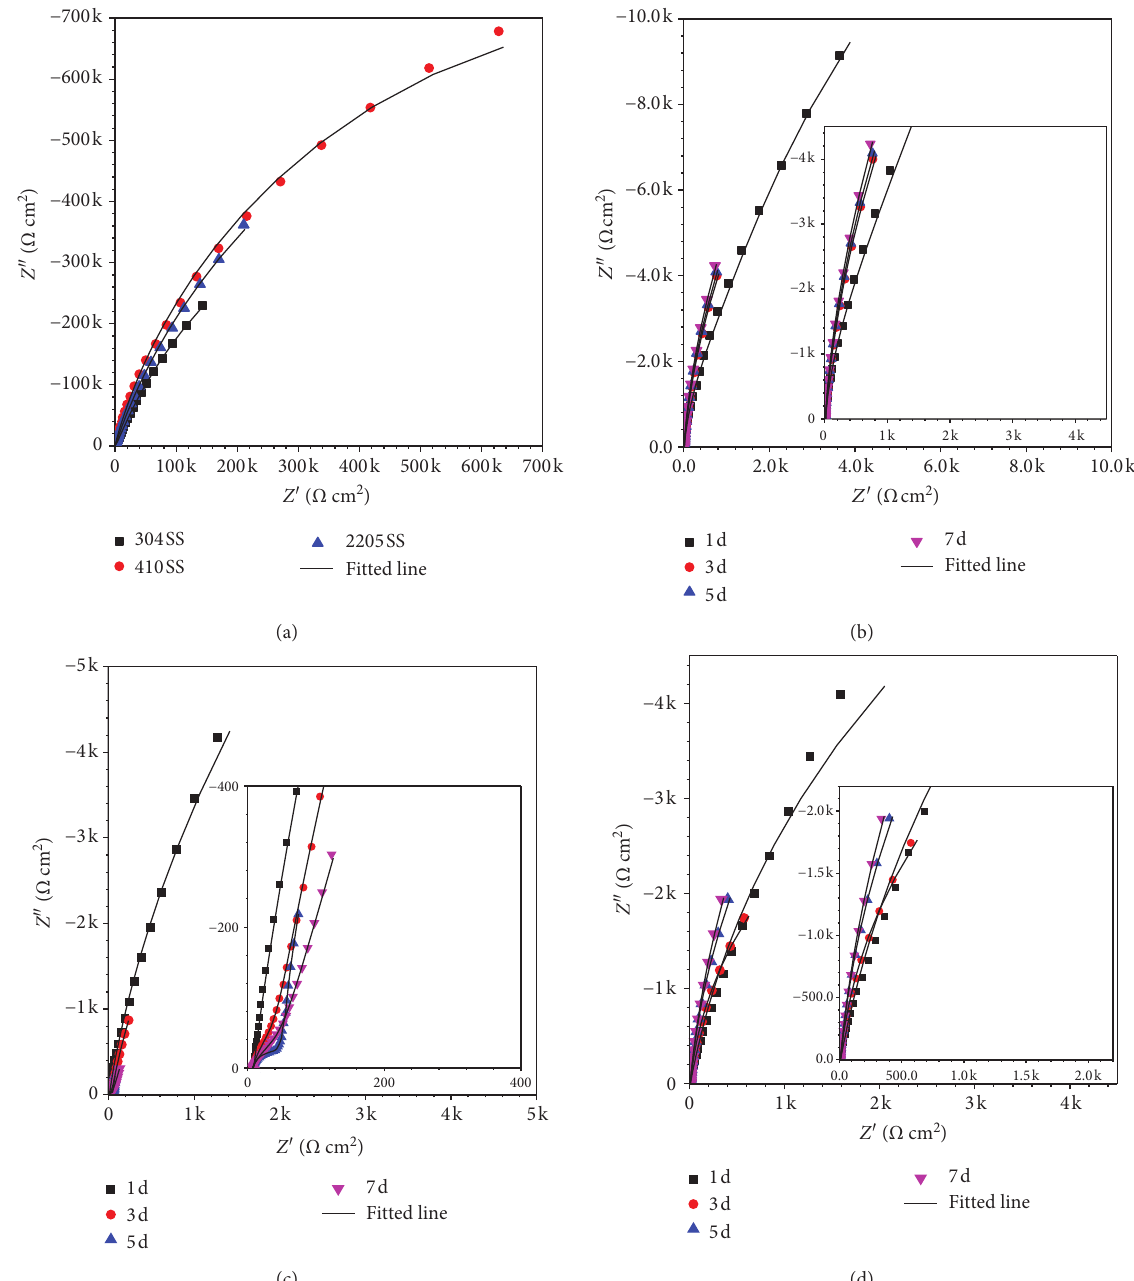
Figure 4: Nyquist plots of three stainless steel types during 7-day incubation. (a) 0 day. (b) 304 SS. (c) 410 SS. (d) 2205 SS.